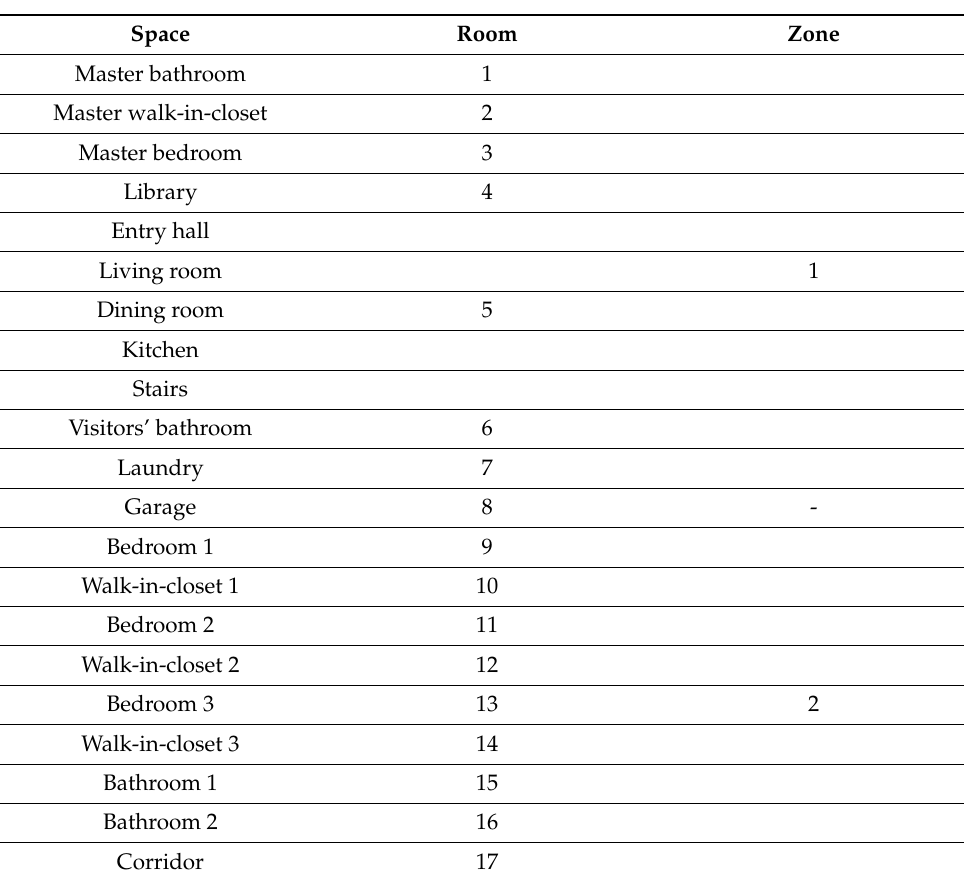
Figure 5. HVAC zones. ( a ) Zone 1; ( b ) Zone 2. Table 4. Rooms and